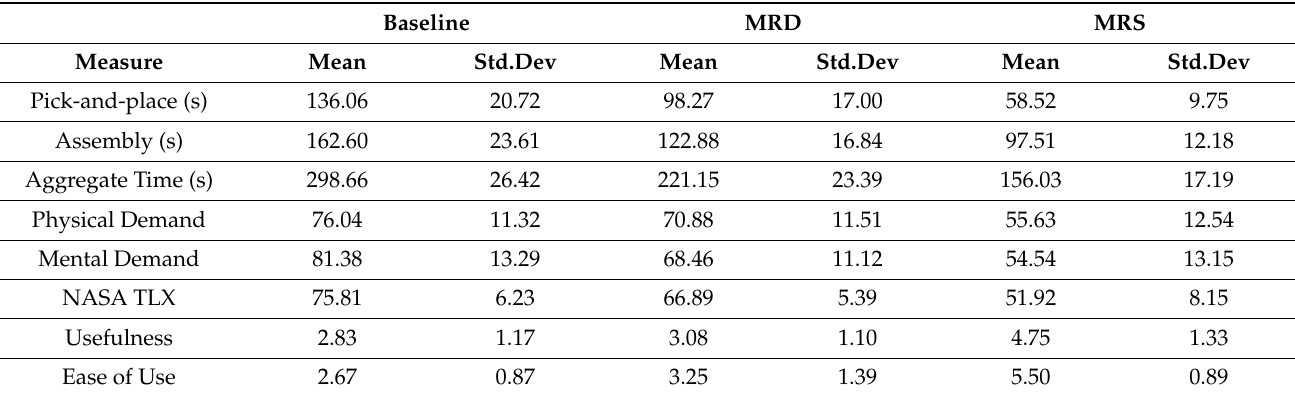
Table 2. Statistical results for objective and subjective measures for each method compared. MRD and MRS denote MR SpaceMouse and MR subspace,